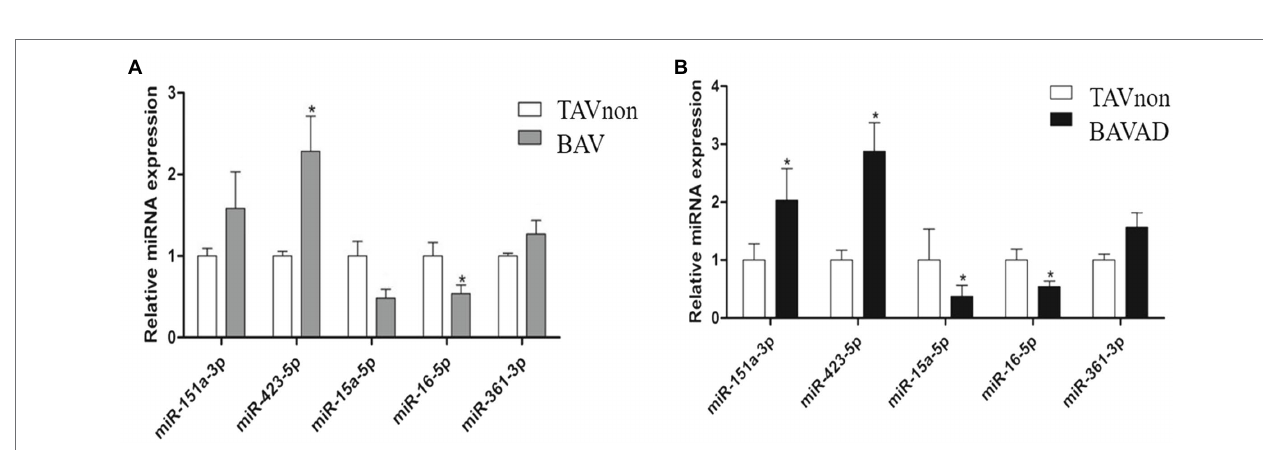
FIGURE 2 | Validation of the candidate DE miRNAs. The selected miRNAs were validated by comparing BAV (A) or BAVAD (B) patients to healthy TAVnon individuals via RT-qPCR. * p <